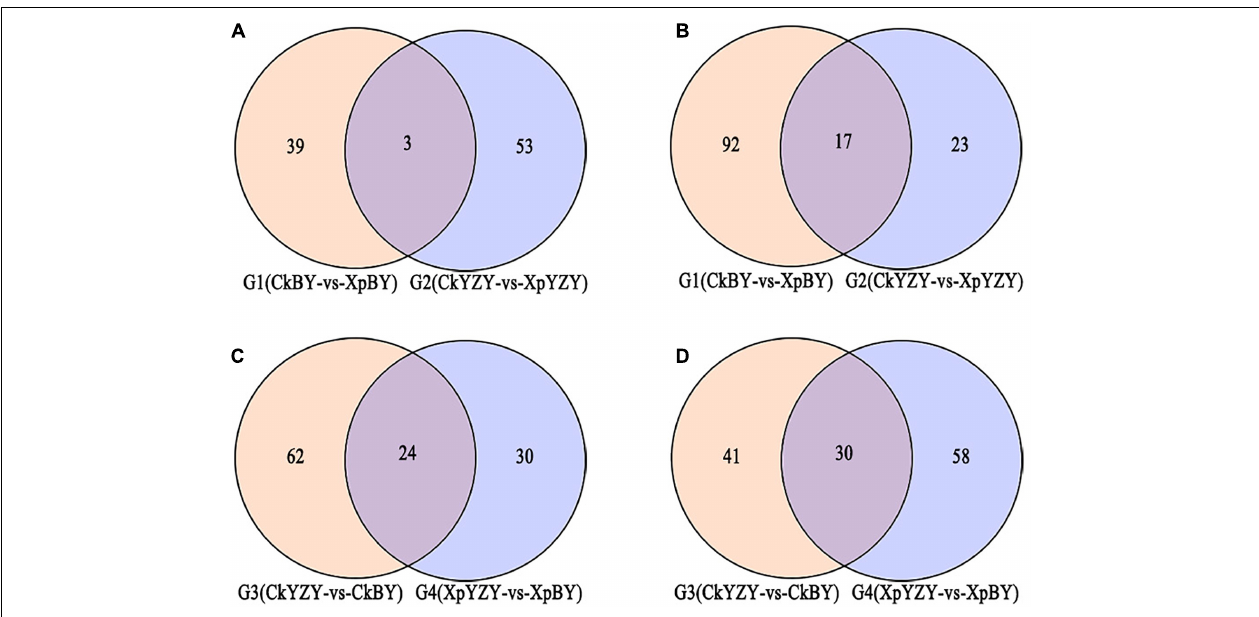
FIGURE 7 | Venn diagram of different metabolites between groups. (A,C) Represent upregulated metabolites and (B,D) represent downregulated metabolites.